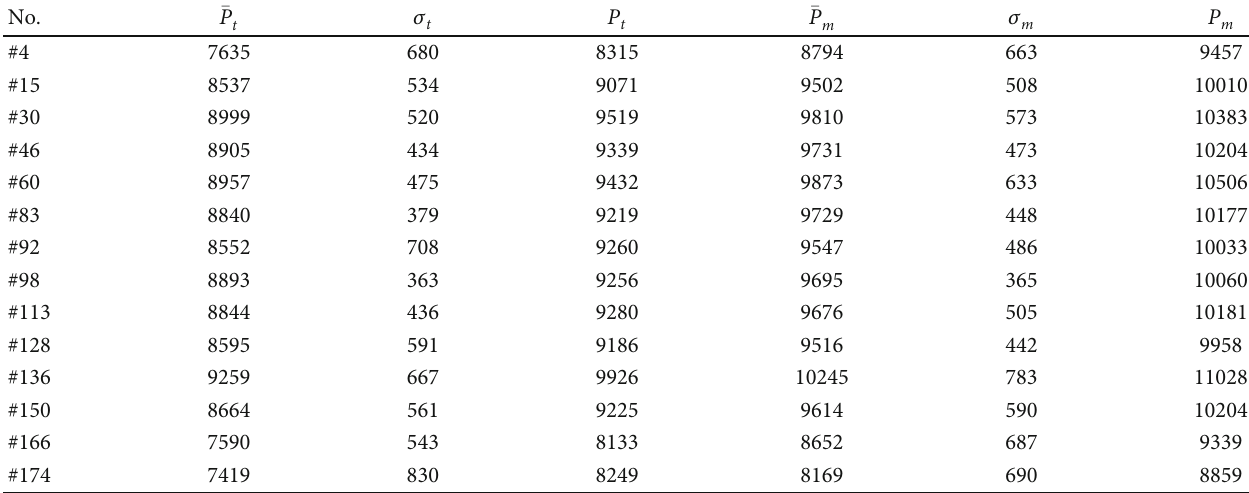
Table 2: Judgment criteria for periodic weighting in some hydraulic